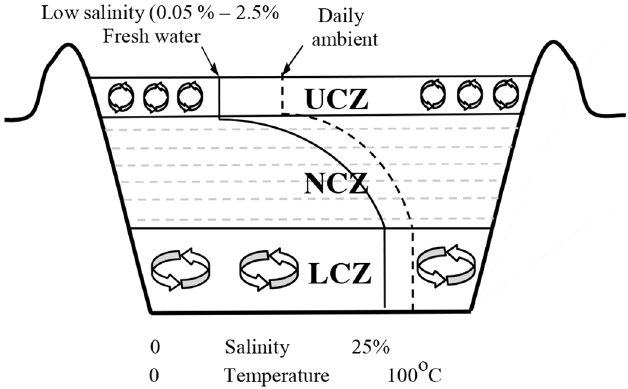
Fig. 1. Diagram of solar pond (salinity